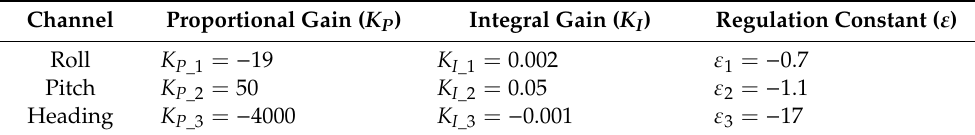
Table 5. Parameters of PI controller and regulator for each orientation experiment in the dynamic test.